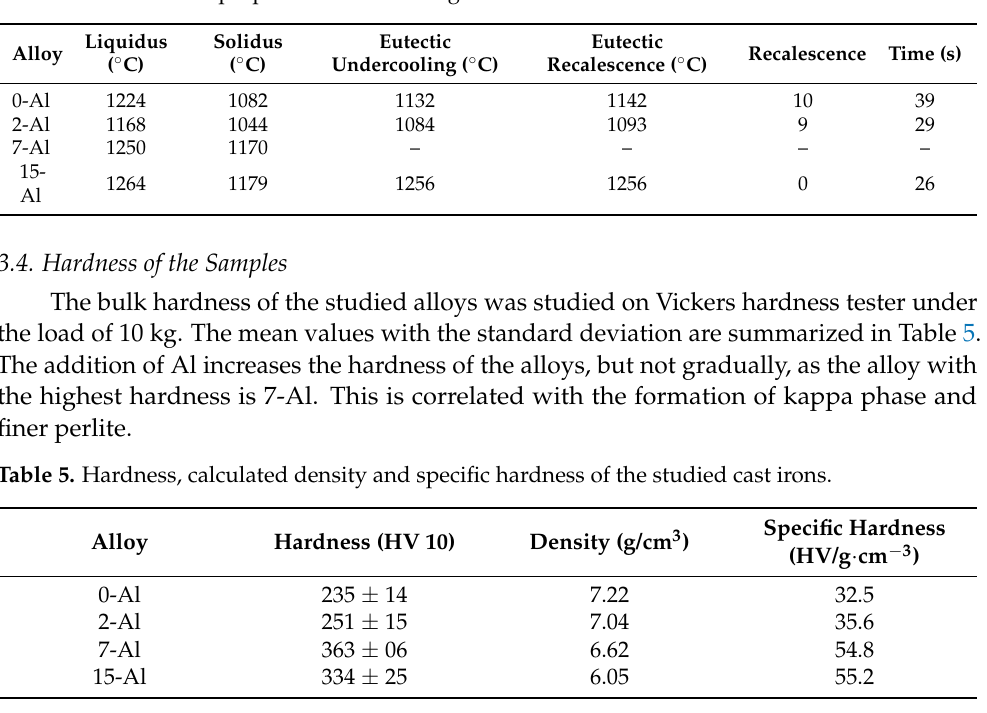
Table 4. Solidification properties of the cooling curves.